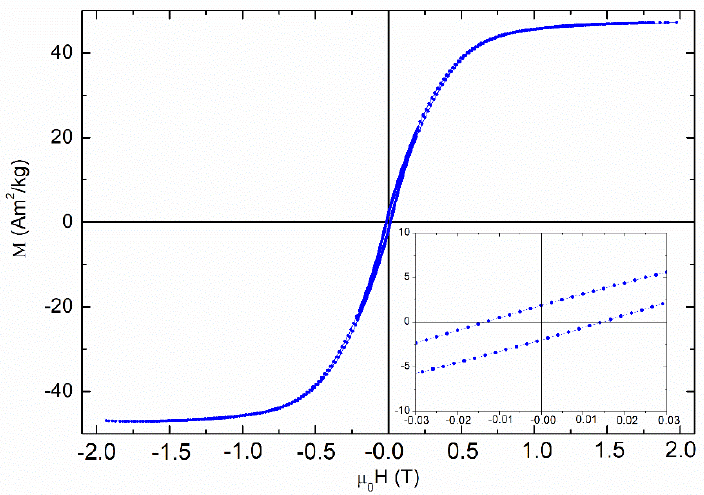
Figure 7. M vs H loop of NaPA@MAC sample recorded at room temperature. The inset presents a magnification focused on the loop’s center to reveal the coercive characteristics.